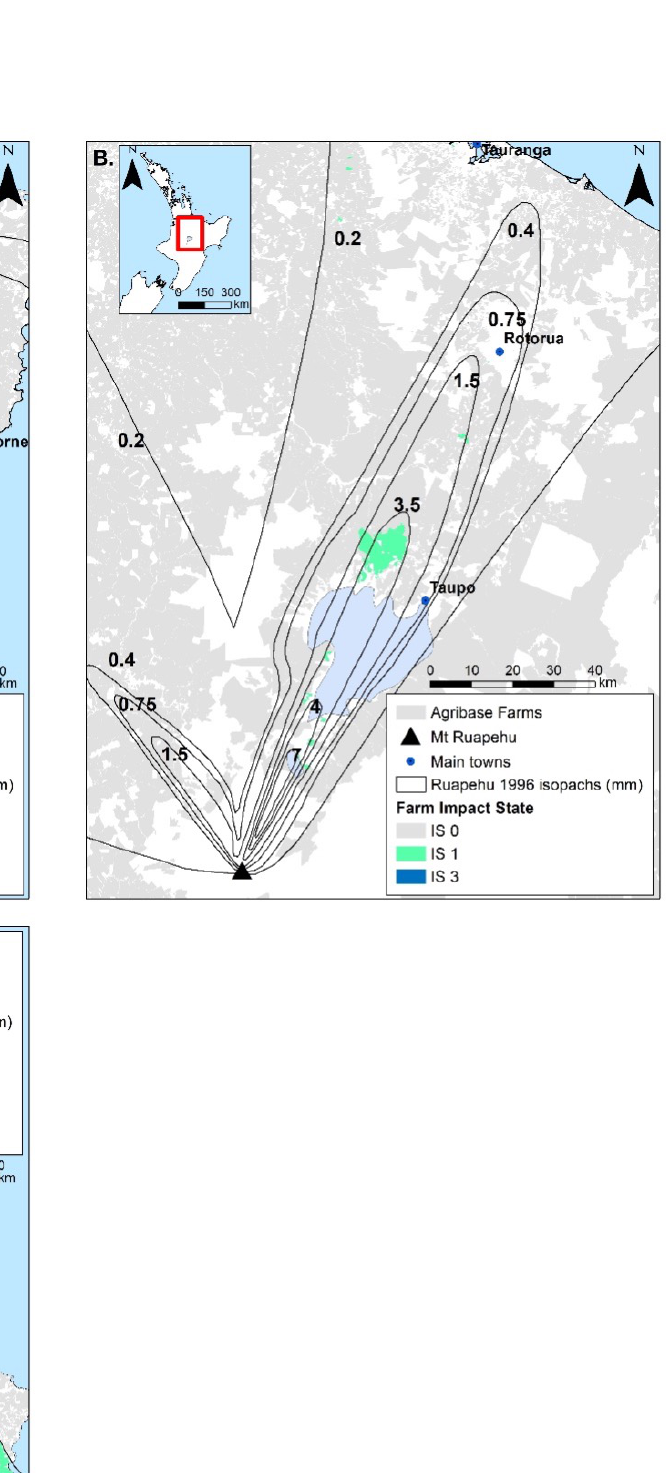
Figure 9: Impact assessment using deterministic sce- narios. [A] October 1995 Ruapehu eruption; [B] June 1996 Ruapehu eruption; and [C] ∼ 1314 CE Kaharoa erup- tion. Isopach maps were taken from Cronin et al. [1998] for the Ruapehu events, and Sahetapy-Engel et al. [2014] for the Kaharoa tephra